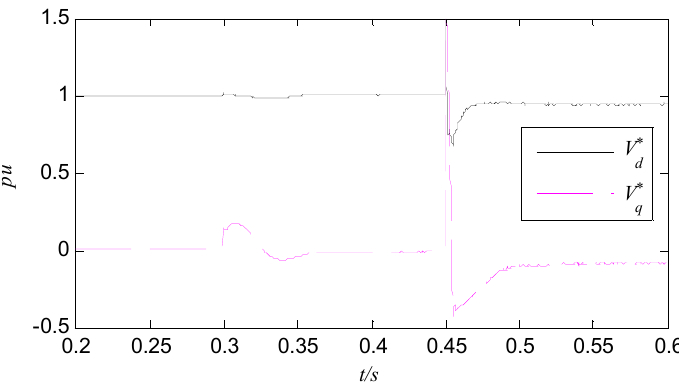
Figure 6. The controller output during the grid-connecting process.